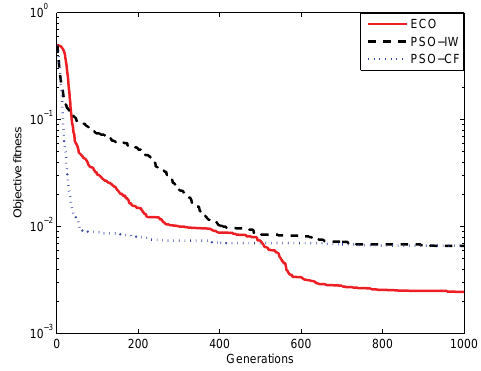
Figure 12: Comparing with two typical methods in the standard PSO algorithm